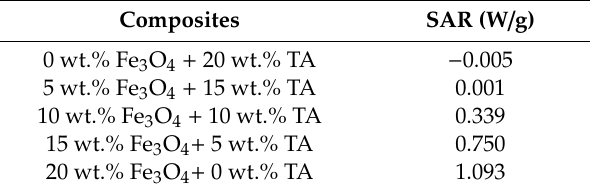
Table 1. Specific absorption rate (SAR) values for S-SEBS polymer with various amounts of TA and Fe 3 O 4